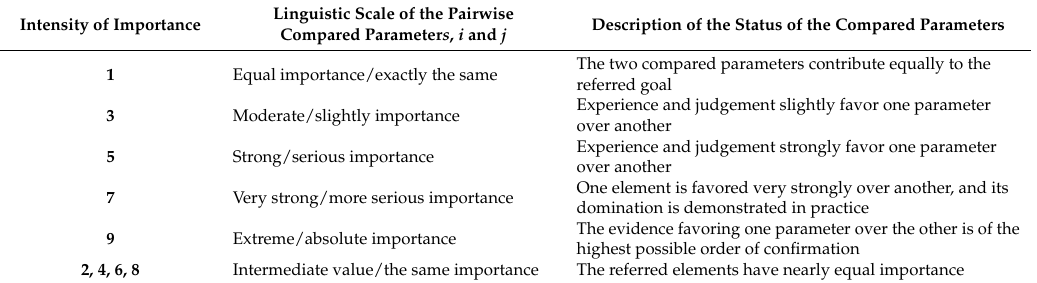
Table 3. The judgement scale for pairwise comparison